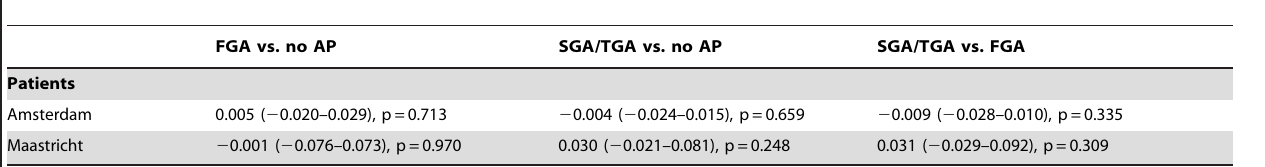
Table 3. Associations between AP medication and